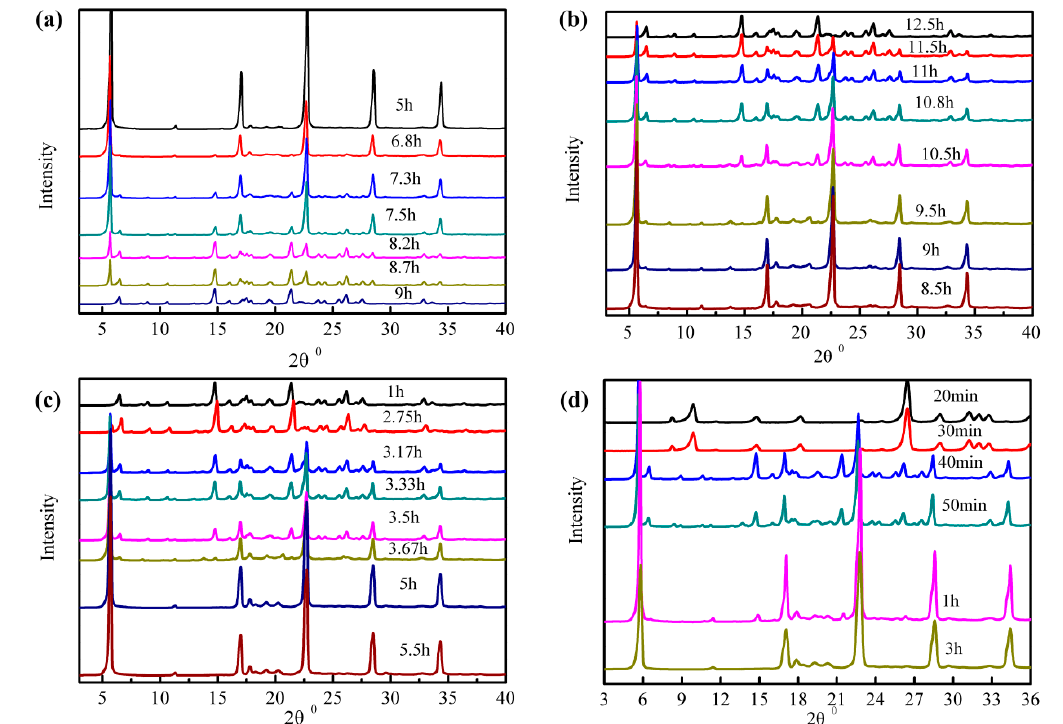
Figure 5. XRD patterns of L-Phe from anhydrate to monohydrate with water activity of ( a ) 0.84 and ( b ) 0.77 at temperature 283.15 K; XRD patterns of L-Phe from monohydrate to anhydrate with water activity of ( c ) 0.84 (c) and ( d ) 0.77 at temperature 323.15 K .